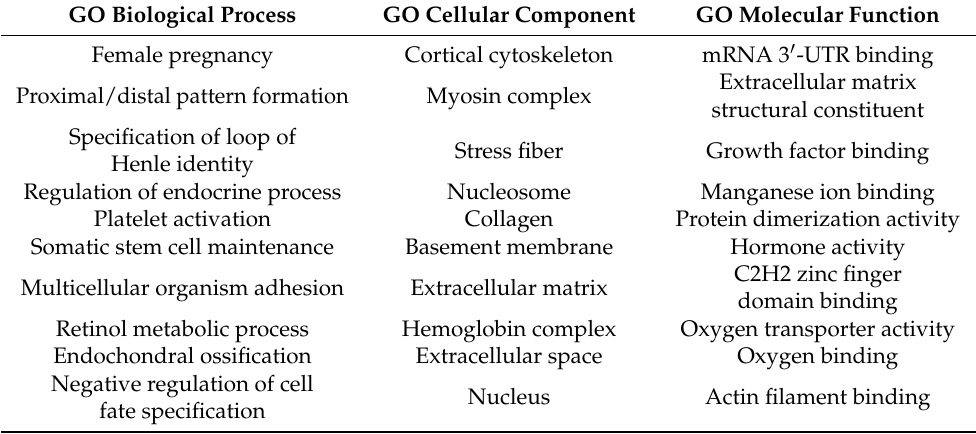
Table 8. Top 10 GO biological processes, cellular components, and molecular functions enriched from differentially expressed genes that are upregulated in MMC spinal cords compared to vehicle at E17. All GO pathways were >1.5-fold and p < 0.05.